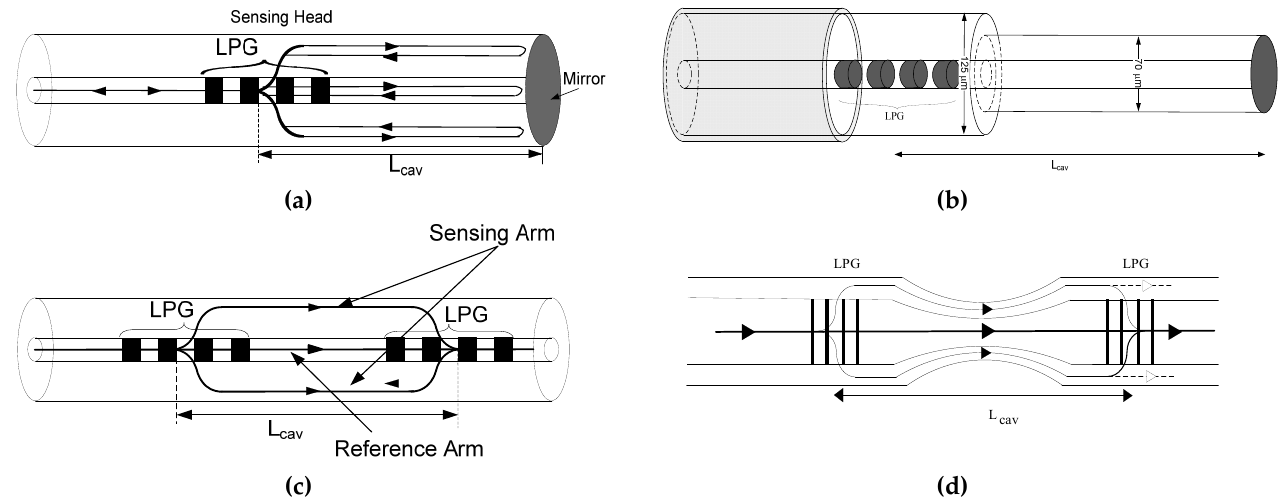
Figure 12. LPG interferometers: ( a ) Michelson configuration; ( b ) Michelson configuration with etching cavity; ( c ) Mach– Zehnder configuration; ( d ) Mach–Zehnder configuration with taper.